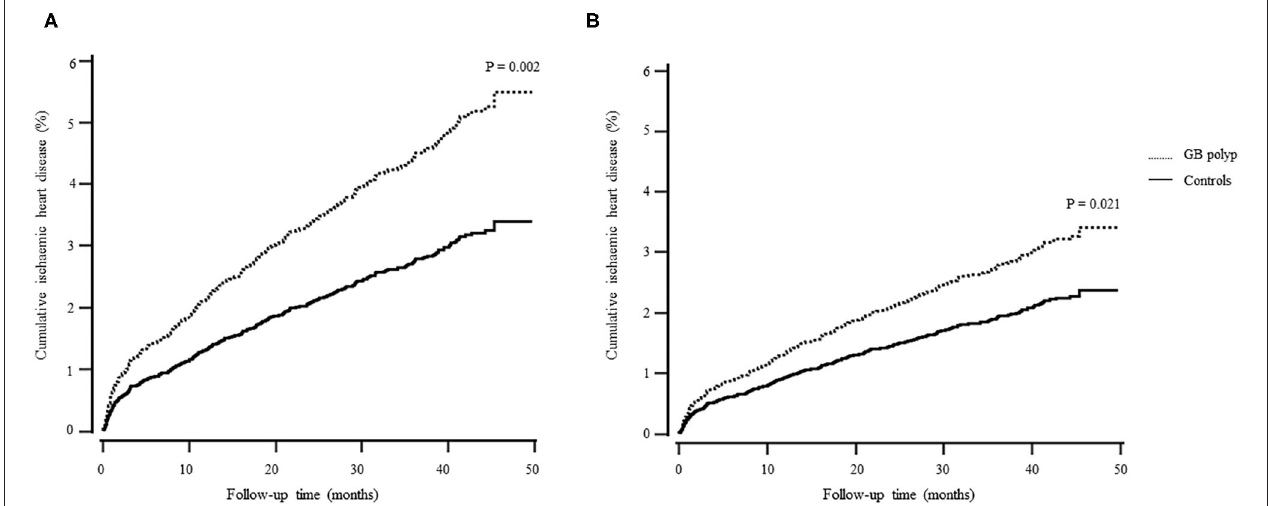
FIGURE 2 | Cox regression survival curve. (A) unadjusted; (B) adjusted for age, sex, hypertension, diabetes, and dyslipidaemia.